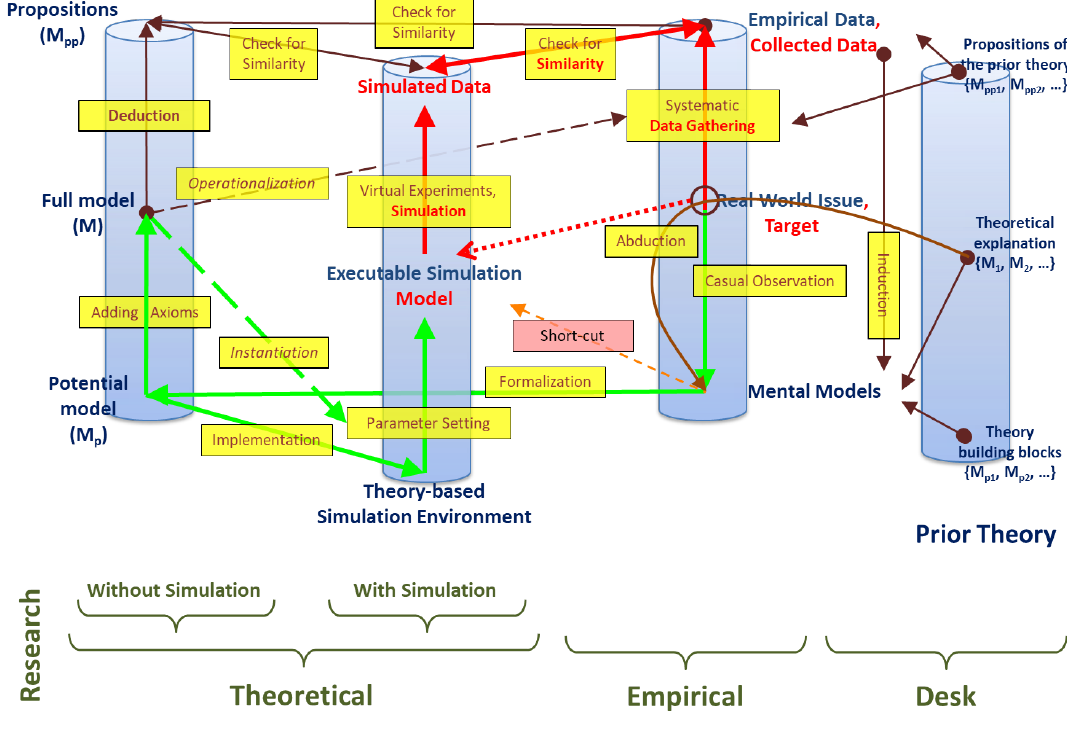
Figure 1. A new research